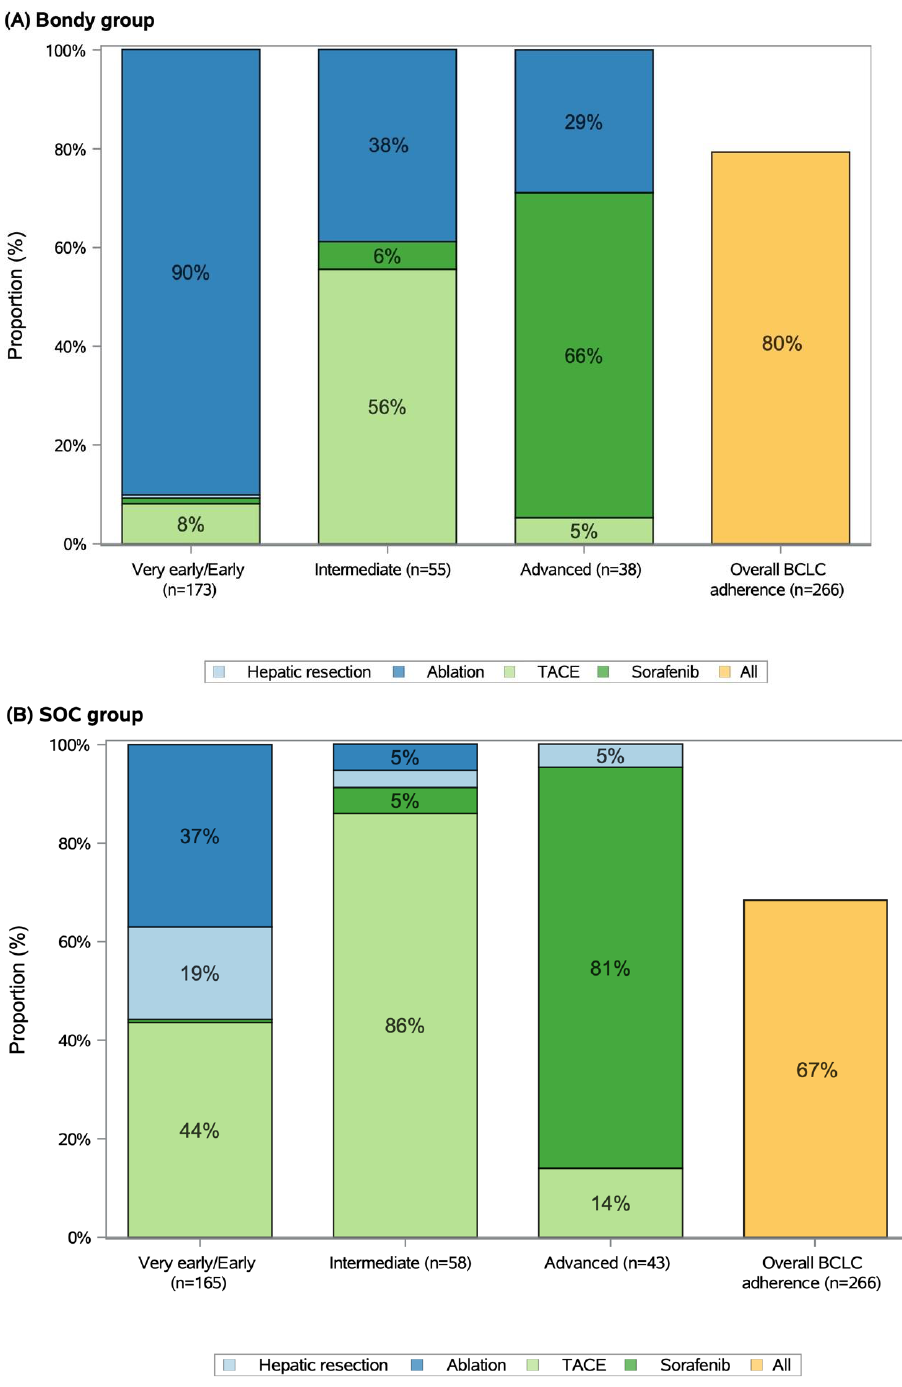
Figure 3. First-line treatment by BCLC stage in the matched ( A ) Bondy and ( B ) SOC